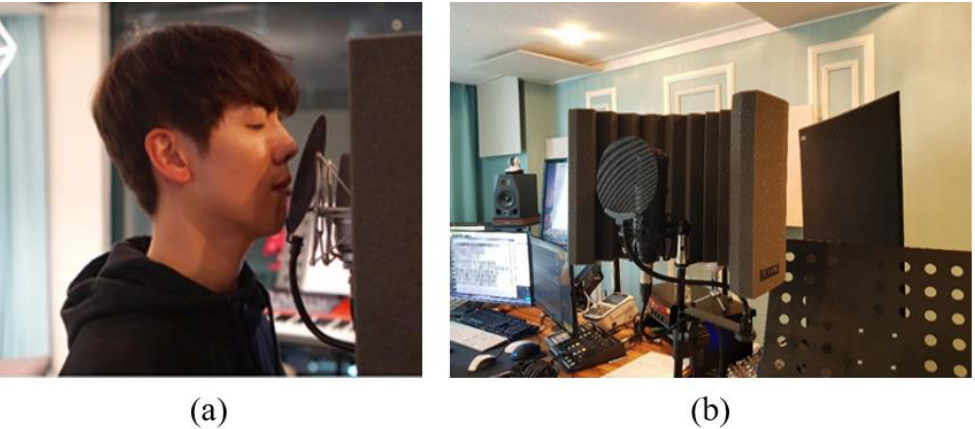
Figure 1. ( a ) One of the actors during recording ( b ) Recording